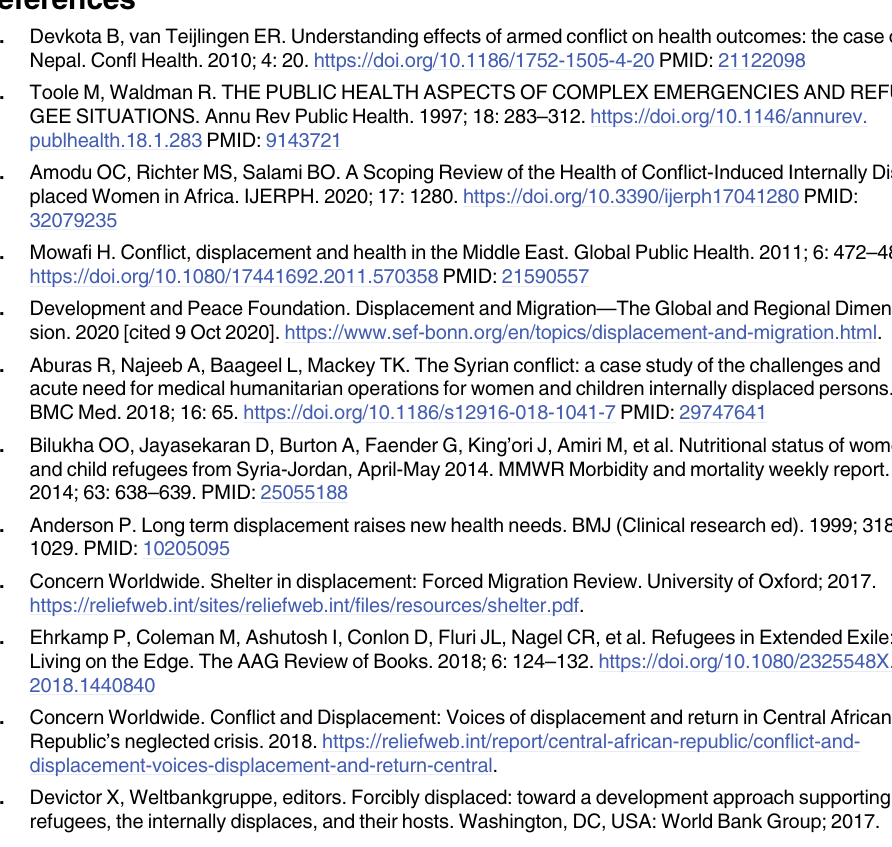
S1 Table. Additional information of the variables that have been categorized in the data